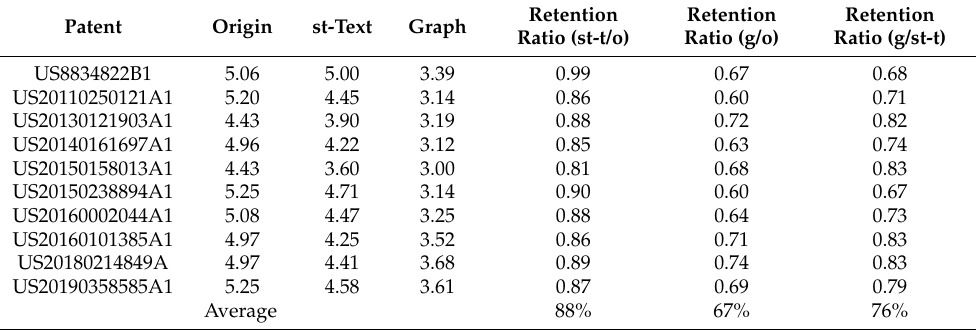
Table 4. Cluster 4 validation